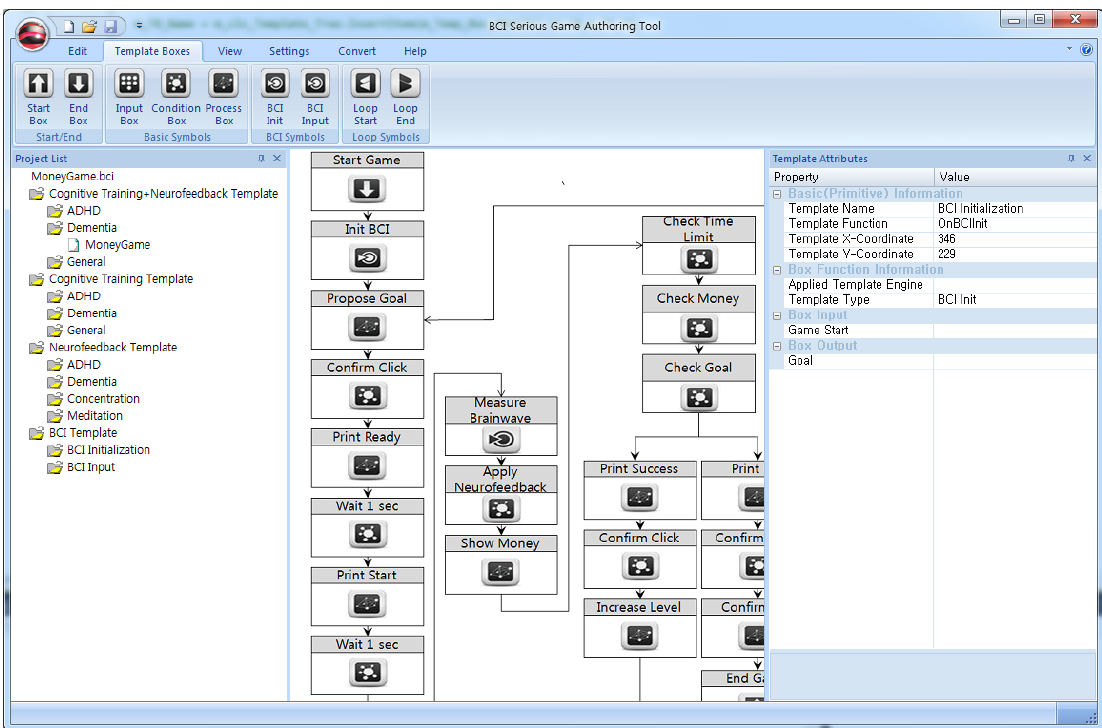
Figure 6. Authoring tool for game designers. game designer authoring tool provides the interface for drawing the flowchart of the BCI serious